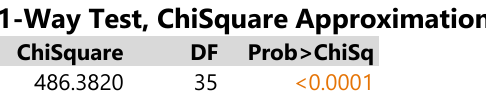
sults of the resources productivity (see Figure 3).